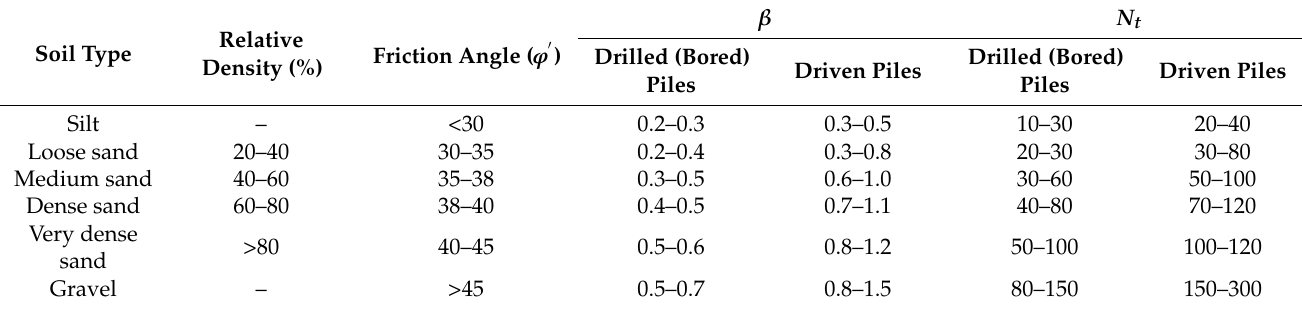
Table 3. Suggested β and N t values based on the soil classification and the CFEM ranges for driven and drilled (bored) piles.